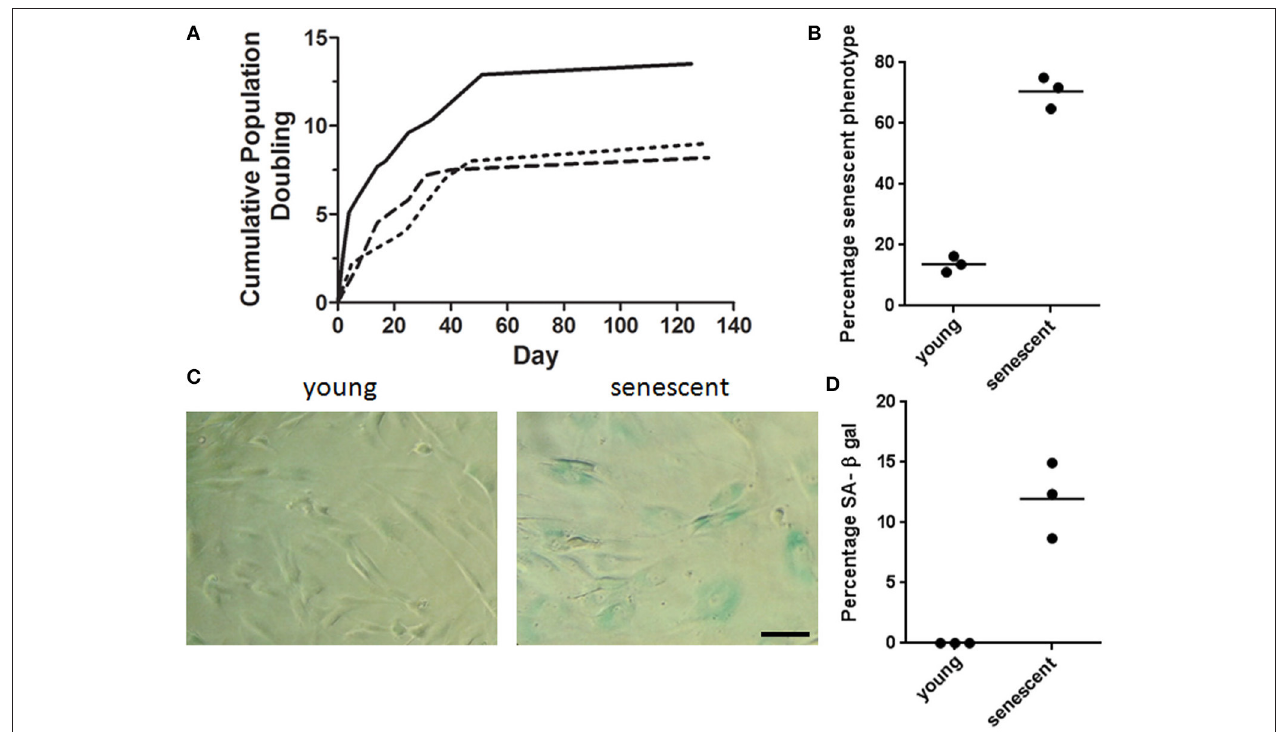
FIGURE 2 | MSCs senescent associated phenotype. (A) Cumulative Population doubling for adipose derived MSCs. Adipose tissue derived MSCs were cultured for a total of 131 days. Cumulative PD were calculated at the end of every passage in relation to cell number of the first passage ( n = 3). (B) Percentage senescent cells determined by cell count/field. Over 60% of MSCs at PD7 acquired a flattened and widened phenotype. (C) Representative brightfield images of young and senescent MSCs. Young cells are spindle shaped and slender in contrast to senescent cells with a widened and flat morphology. Cells presenting blue staining indicate the presence of β -galactosidase activity in senescent cells. Scale bar 100 µ m. (D) Quantification of β -galactosidase positive cells for young (PD2) and senescent cells